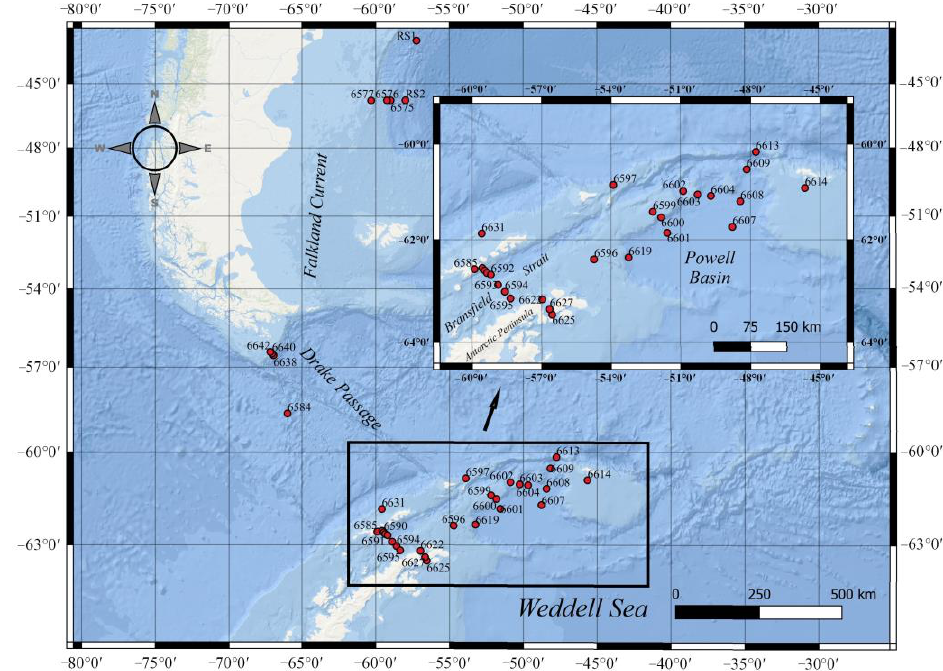
Figure 1. Station map showing station locations (black circles) covered during cruise No. 79 of RV “Akademik Mstislav Keldysh” from 11 January–4 February 2020.